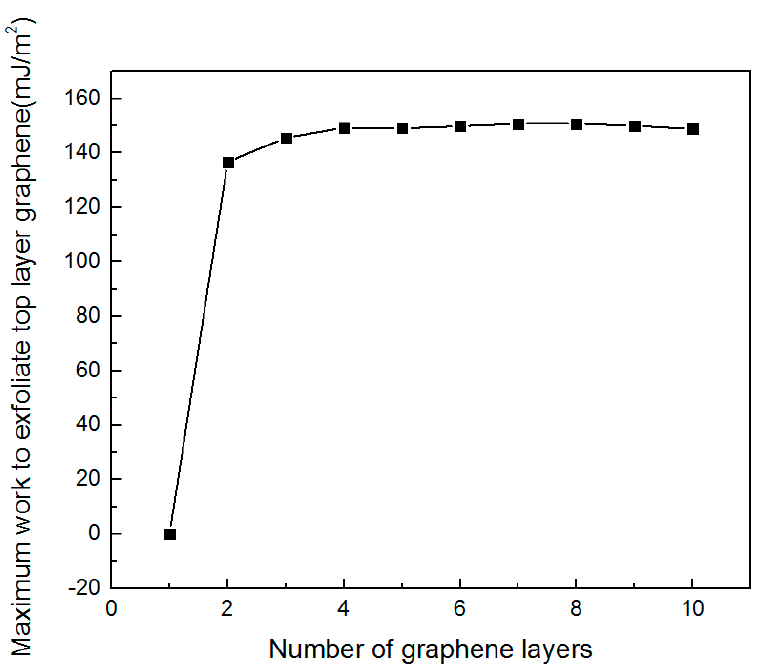
Figure 17. The maximum work to exfoliate the topmost layer. In addition, the graphene edges are sometimes passivated by hydrogen, oxygen or nitrogen atoms. In this paper, in order to explore the influence of the edge termination on the exfoliation property, the edge of graphene is passivated by hydrogen in the two- layer graphene system. The critical velocity to exfoliate the topmost layer is higher in the hydrogen-terminated graphene system (13 Å/ps) than that in the unsaturated graphene system (12.1 Å/ps). This is because the hydrogen-terminated graphene system is more stable, it can be seen that the total energy is − 56,067 eV, which is lower than that in unsaturated graphene system ( − 53,541 eV) as shown in Figure 18c.